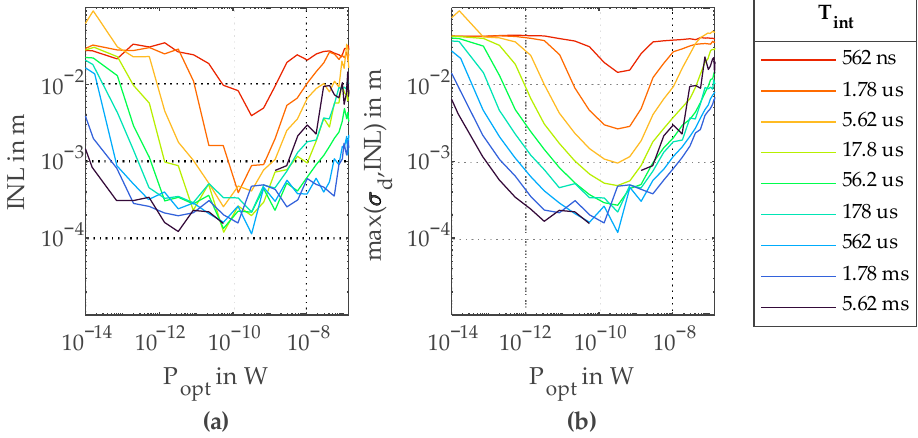
Figure 9. ( a ) Integral nonlinearity INL over P opt for different T int ; ( b ) maximum of INL and σ d over P opt for different T int .